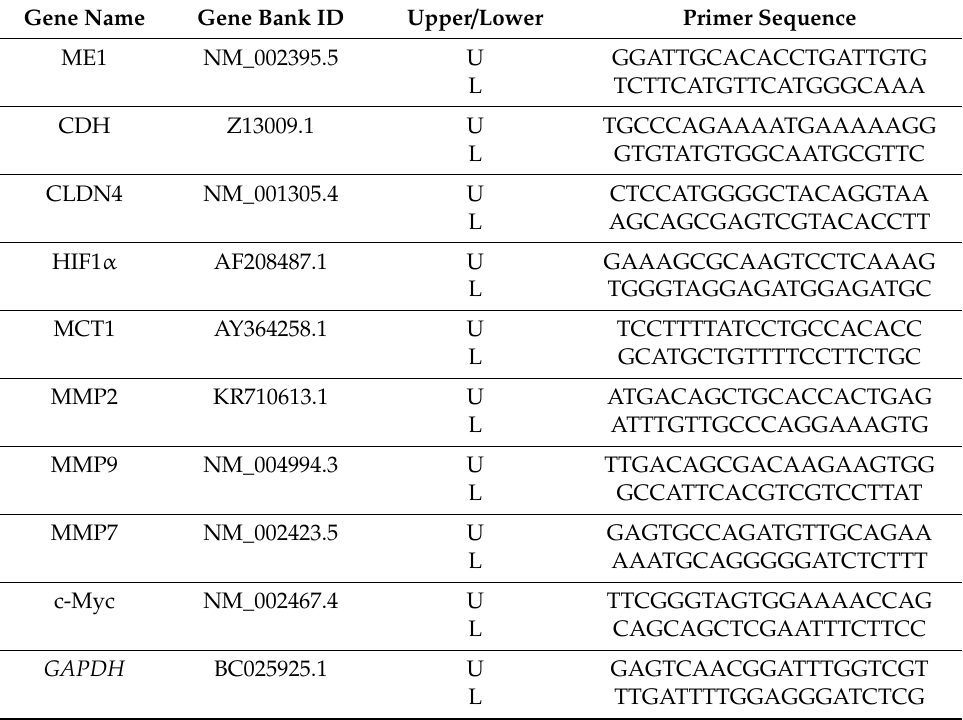
Table 3. Primer sets for